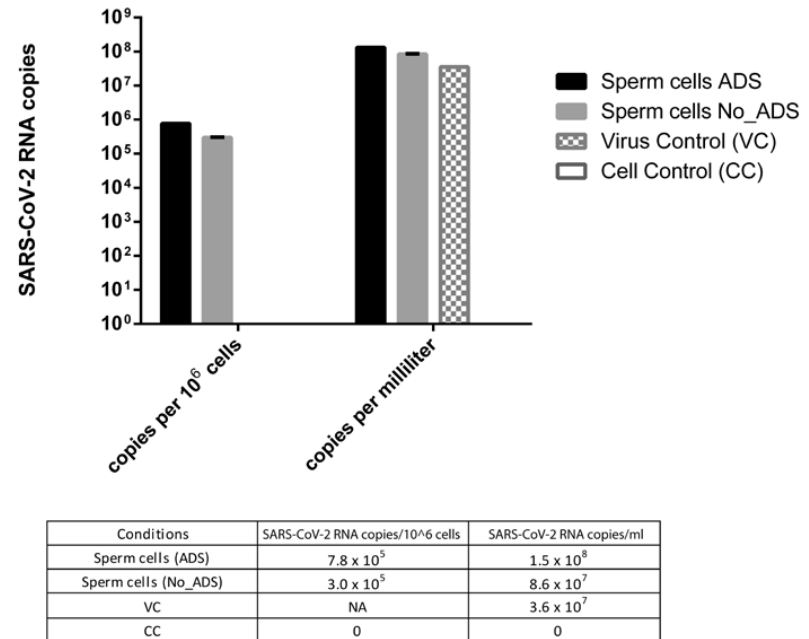
Figure 4. SARS-CoV-2 RNA amount in infected sperm cells with (ADS) or without (NO_ADS) viral absorption, expressed as viral RNA copies per million sperm cells and as viral RNA copies per millilitre. The virus control (VC) subjected to swim-up in the absence of sperm cells to estimate the residual viral inoculum was expressed only as RNA copies per millilitre. CC: uninfected sperm cells, NA: not applicable.